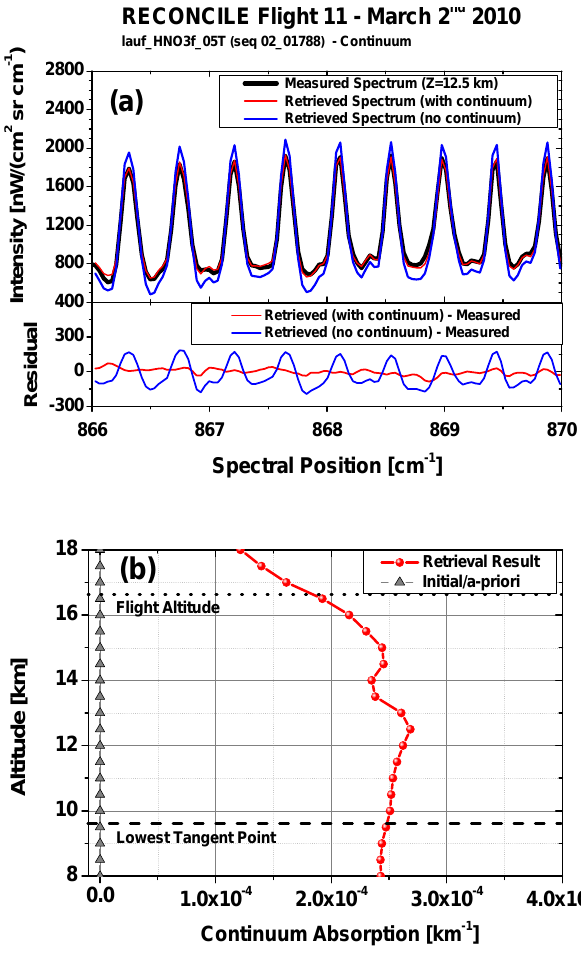
Fig. 9. (a) Measured spectrum (black) and retrieved spectra with (red) and without (blue) background continuum retrieval for a flight altitude of 16.7km and a tangent altitude of 12.5km for the HNO 3 - retrieval and residuals. (b) Associated retrieval result for continuum absorption of the corresponding full limb